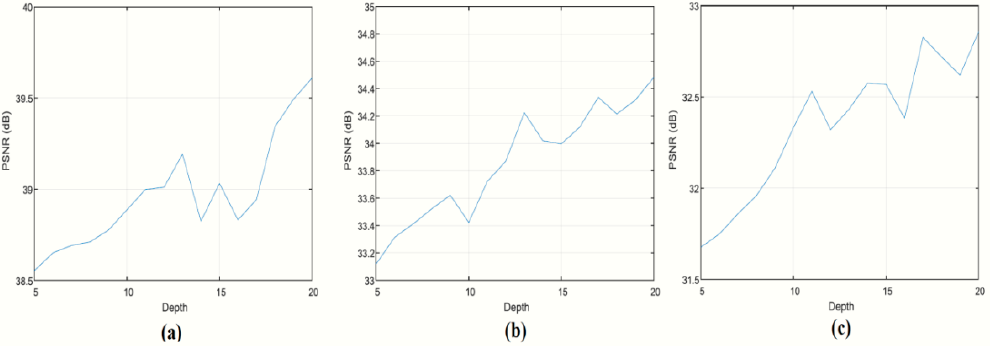
Figure 4. Depth performance of the network on dataset Set5: ( a ) at scale 2, ( b ) at scale 3, and ( c ) at scale 4.